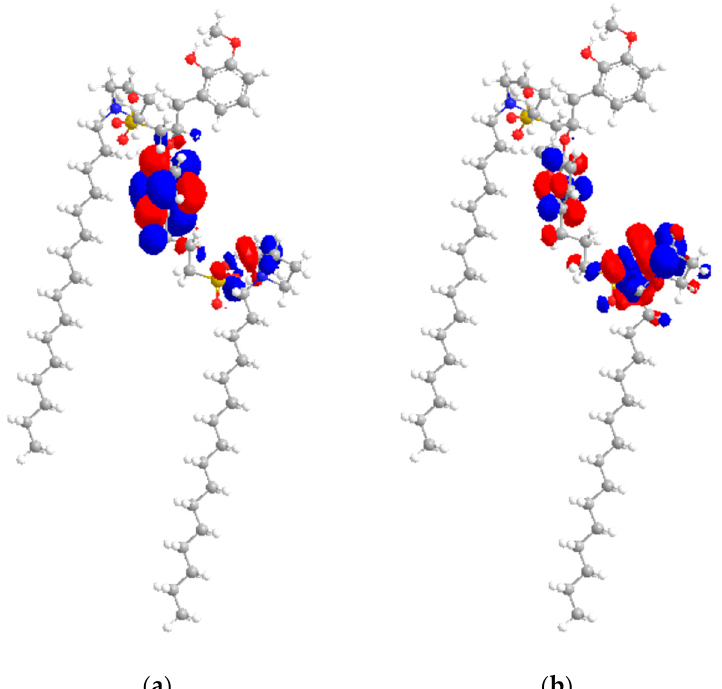
Figure 13. ( a ) HOMO location of [C 16 C 1 Pip] 2 [LS]; ( b ) LUMO location of [C 16 C 1 Pip] 2 [LS]. Yellow, blue, grey, white and red respectively, represented sulfur, nitrogen, carbon, hydrogen and oxygen.